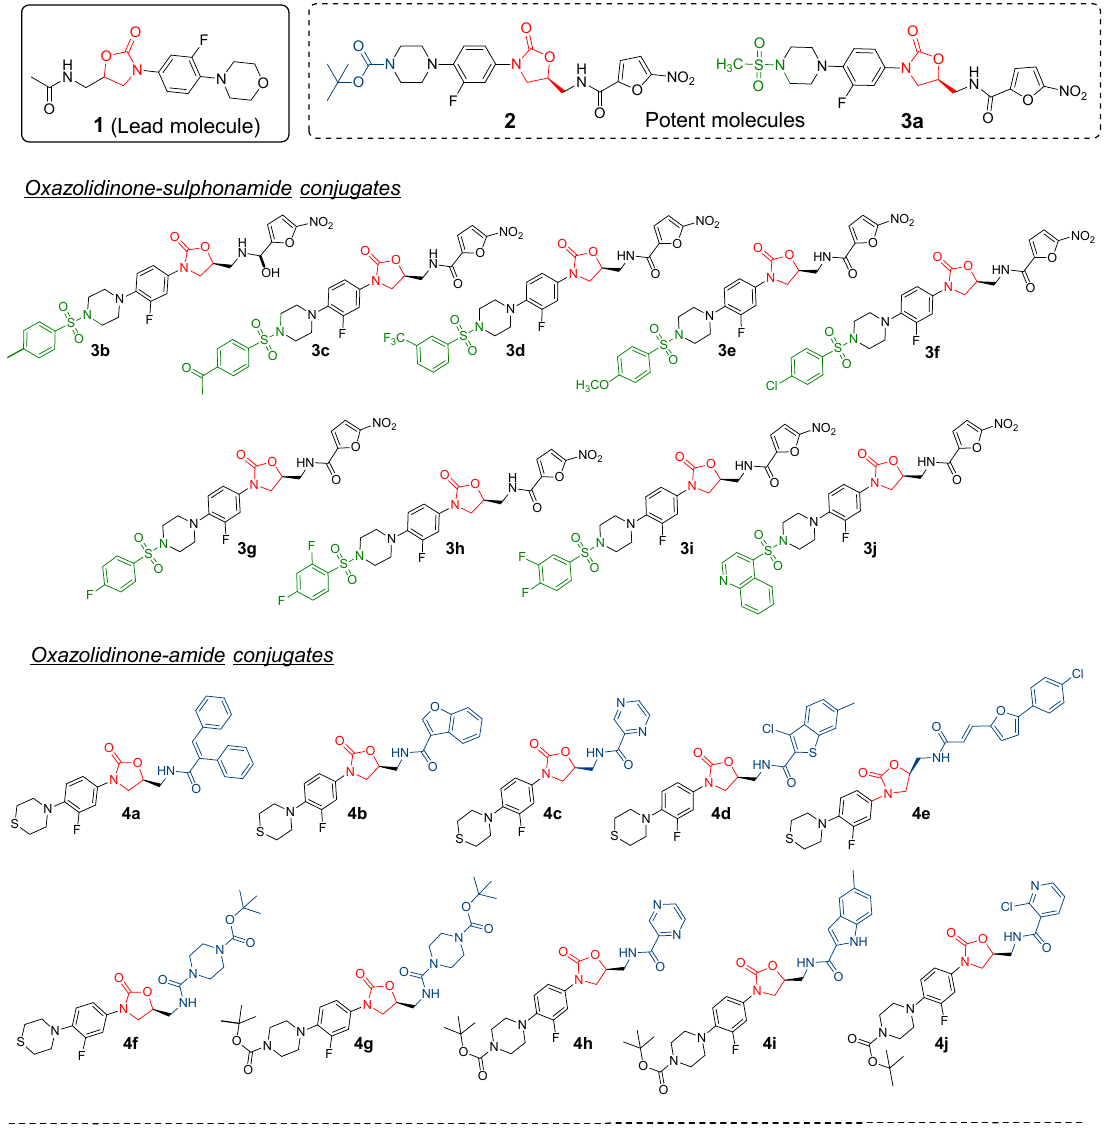
Figure 2. Design of novel linezolid-based oxazolidinones [24].